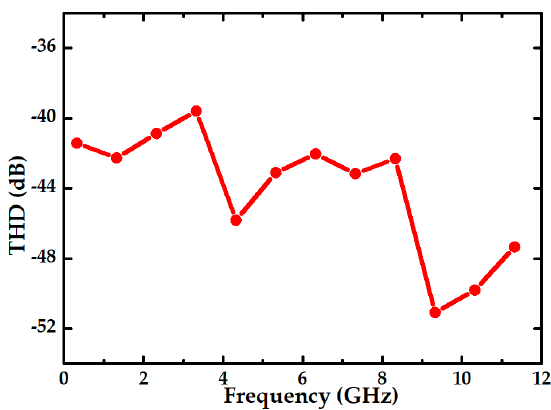
Figure 14. Measured THD ( − 3dBm input).